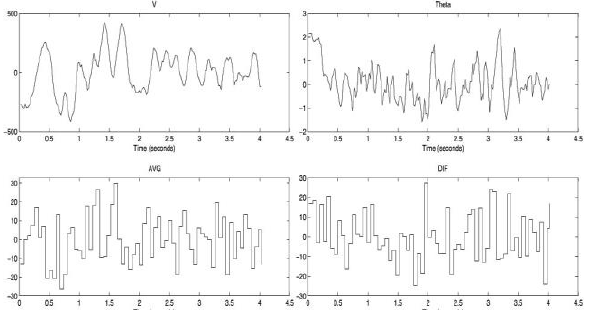
Figure 9. Output vx ,  and input commands used for white noise signal